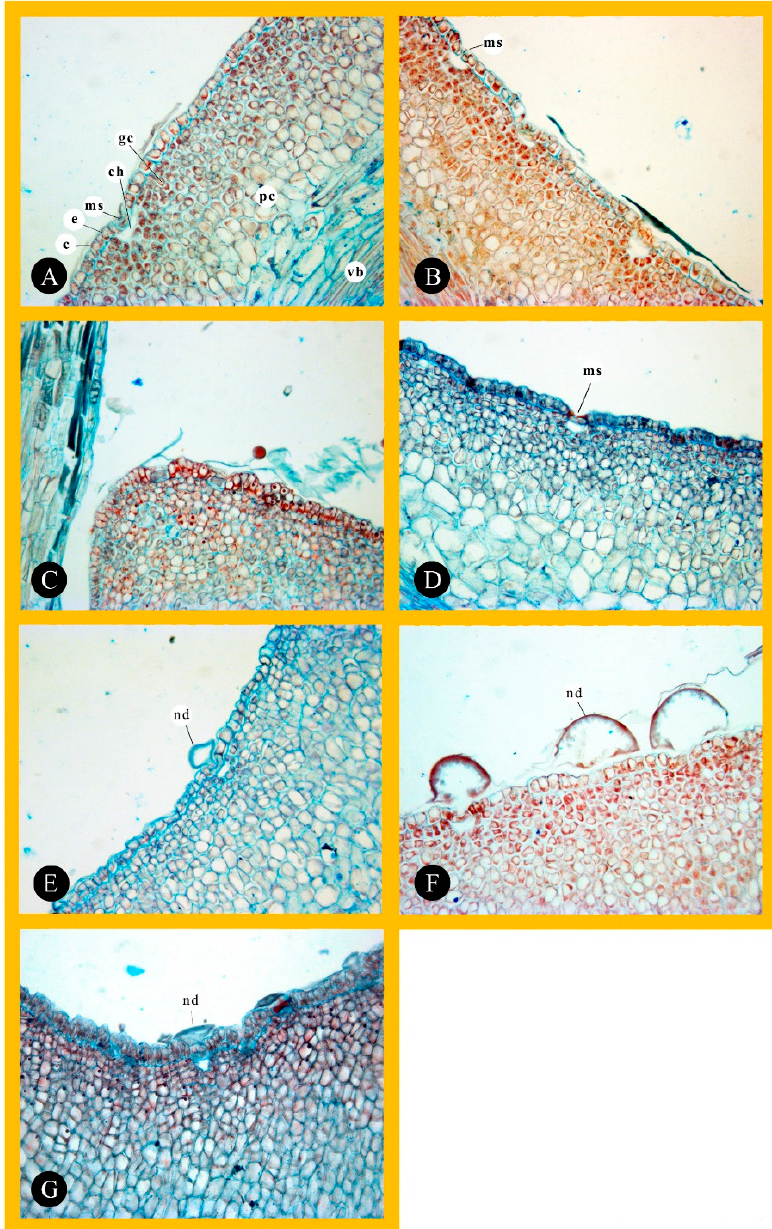
Figure 6. Fragments of longitudinal sections of a flower receptacle at the level of the nectariferous tissue of the hypanthium showing distinct glandular and subglandular tissue nectaries in eight pear cultivars comparatively; × 20, LM. ( A ) Aleksander Lucas (low susceptible), ( B ) Bella di Guigno (moderately resistant), ( C ) Chojuro (highly resistant), ( D ) Kieffer (highly resistant), ( E ) Williams (susceptible), ( F ) Poire de Cure (moderately resistant), ( G ) Nijisseiki (highly resistant). Abbreviations: c—cuticle; nd—nectar droplet; ms—modified stomata; e—epidermis; ch—sub-stomatal chamber; gc—glandular cells; pc—non-glandular parenchimal cells; vb—vascular bundle.